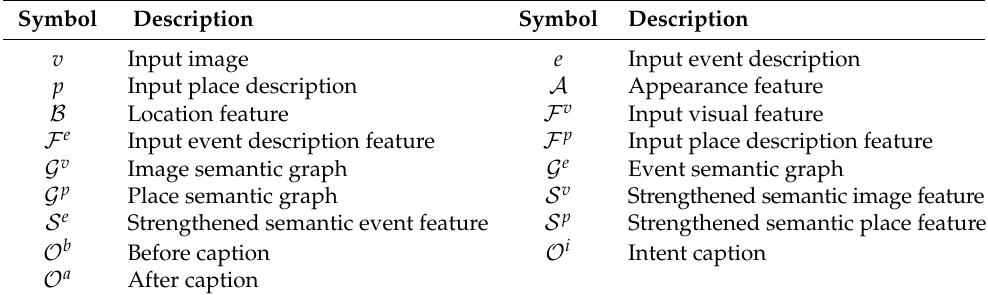
Table 1. Descriptions of the important symbols used in this